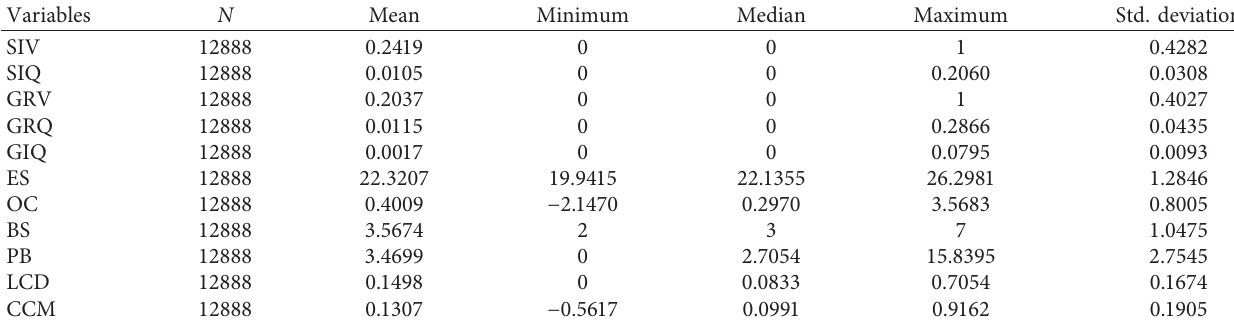
Table 2: Descriptive